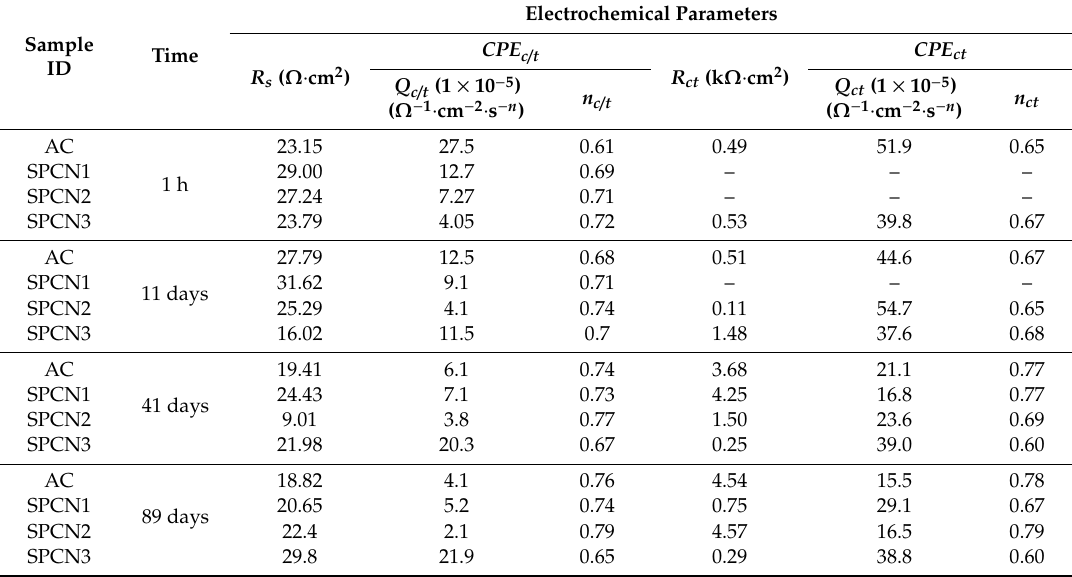
Table 3. Electrochemical parameters after fitting of electrochemical impedance spectroscopy (EIS) plots in appropriate EECs at di ff erent durations of exposure in 3.5 wt.% NaCl solution.